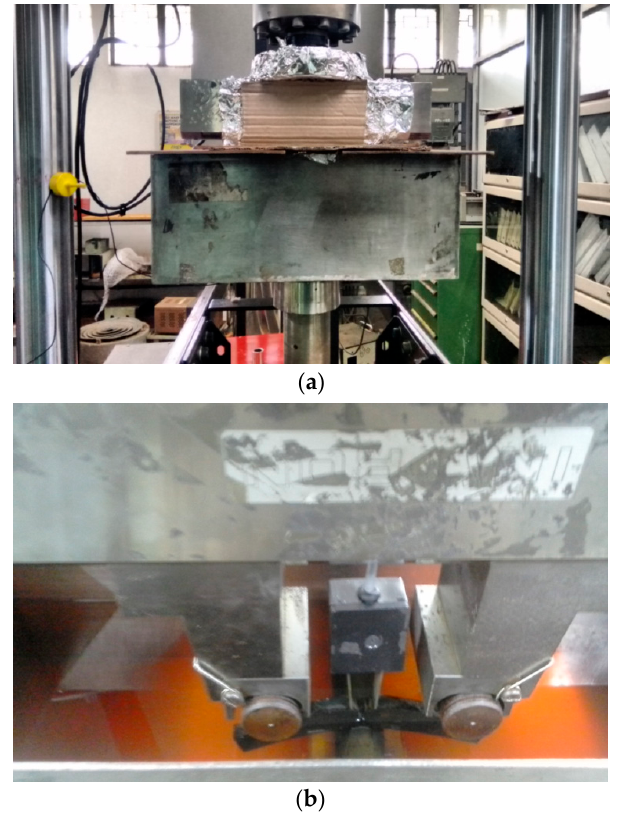
Figure 3. Test Set-up showing ( a ) the covering of the tank to minimize evaporation and ( b ) the sample loaded in three-point bending and the test solution.